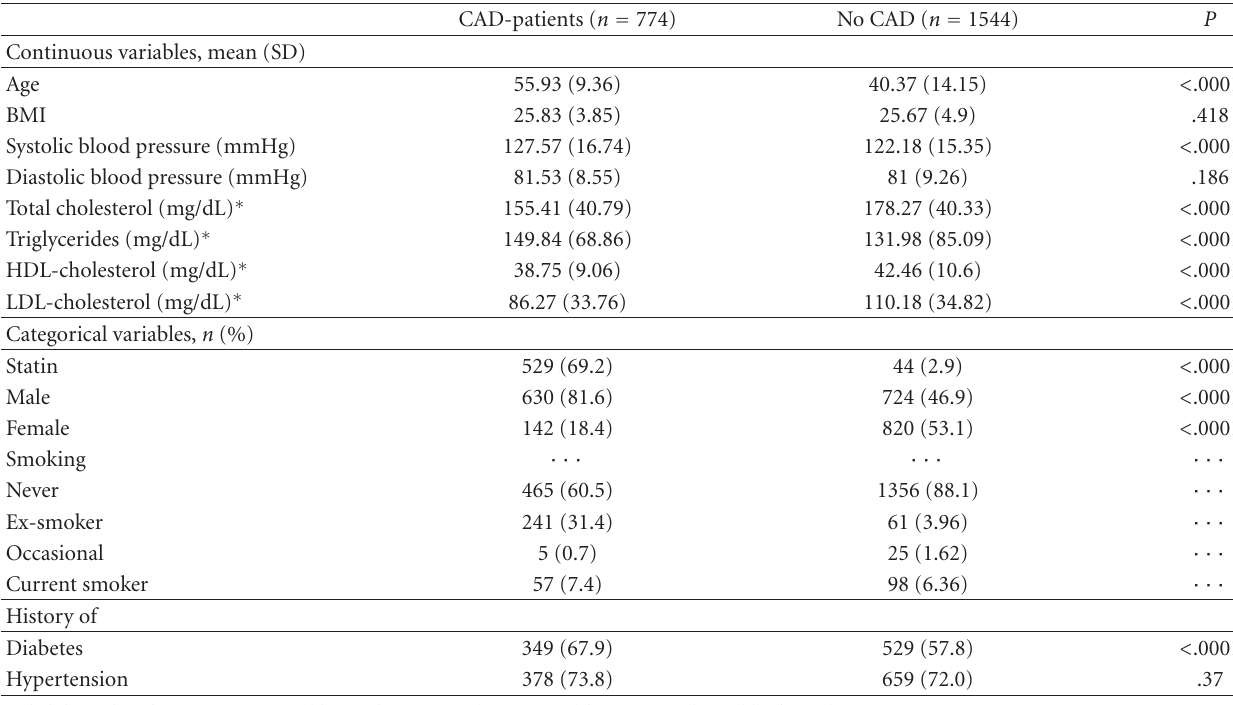
Table 1: Baseline characteristics of study participants.